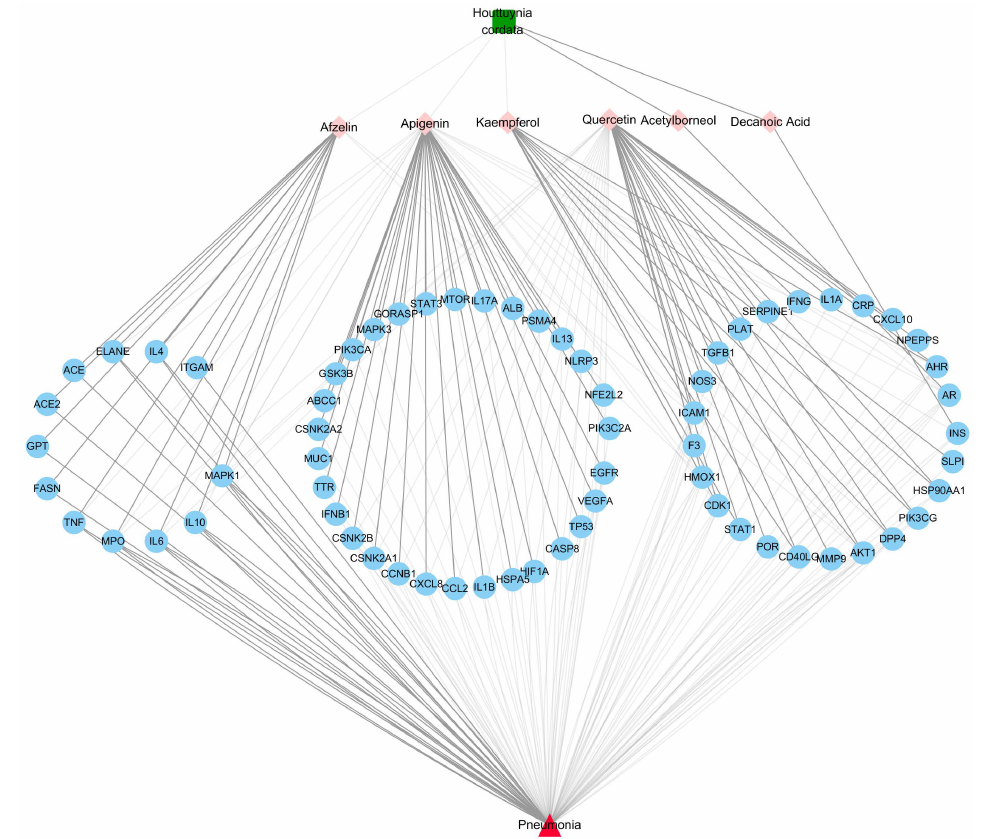
Figure 2. Herb-Metabolites-Targets-Disease network (HMTD) of Houttuynia cordata . The green square represents the herb Houttuynia cordata ; pink diamonds are the active ingredients of Houttuynia cordata ; blue circles are common targets resulting from the intersection of herb targets and disease targets; the red triangle is the disease.